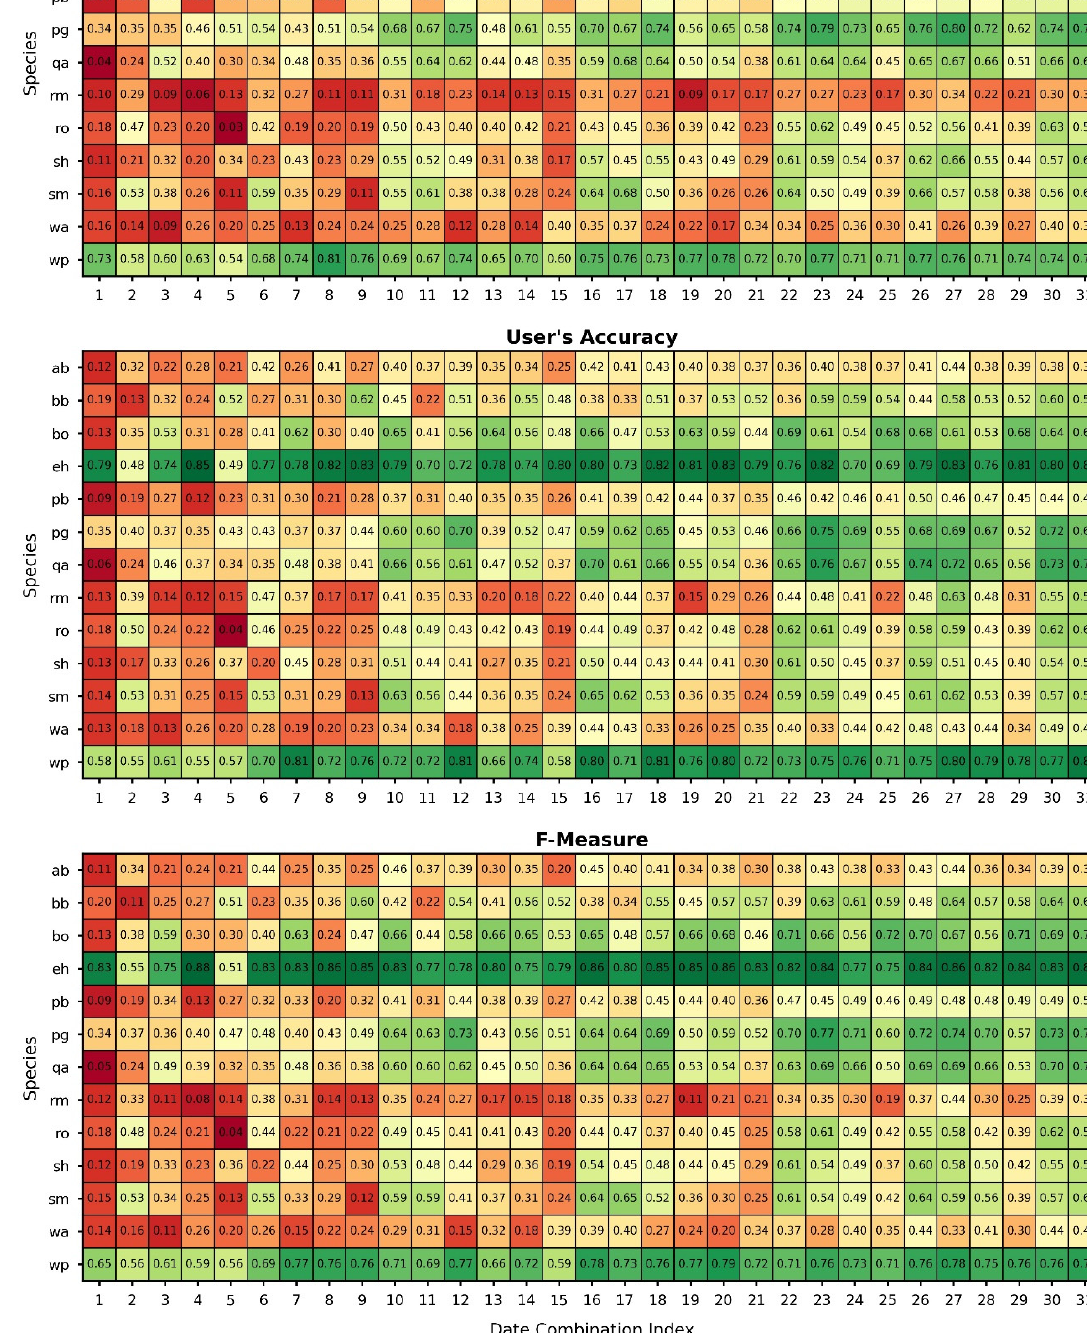
Figure 3. Producer’s accuracy, user’s accuracy, and F-measure for all Aeria classifications. The values on the x-axis are the index values assigned to each classification (see Table 3). The y-axis is the species abbreviation (see Table 2).